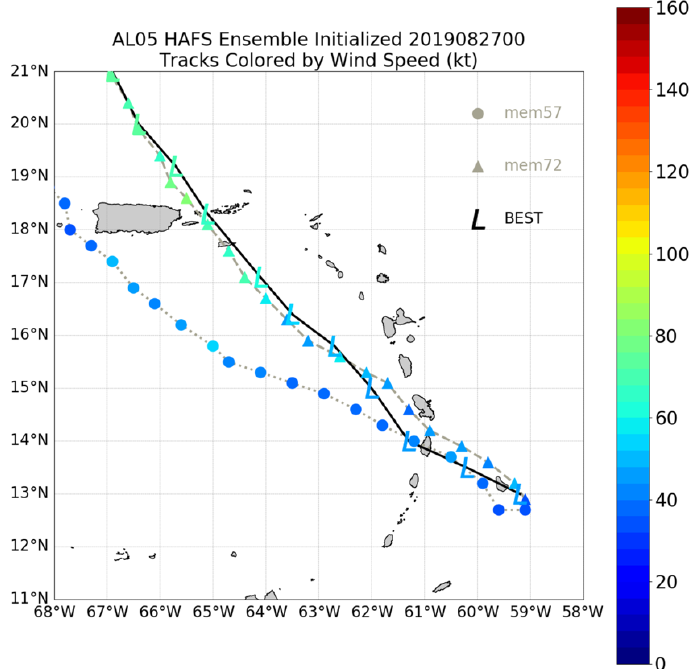
Figure 9. Tracks from the weak member (gray line with circles) and strong member (gray line with triangles) in the early forecast period in the northeast Caribbean. The observed track from Best Track is shown on the black line with “L” symbols. The tracks are shaded by maximum wind speed in kt (1 kt = 0.51 m s − 1 ).